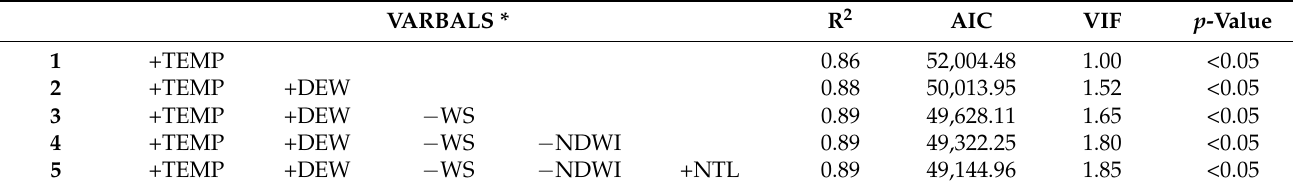
Table 3. Results of the multiple stepwise regression model.